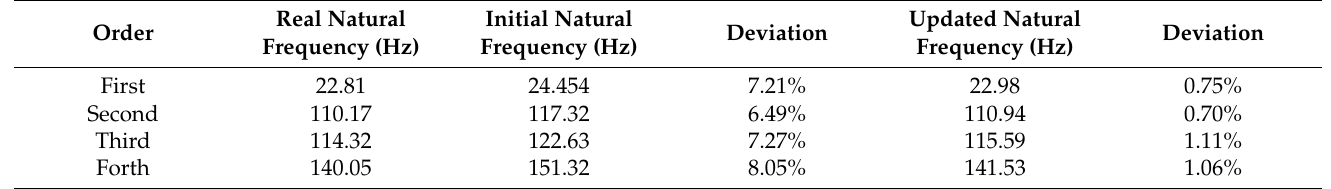
Table 12. The comparison of real natural frequency, initial natural frequency and updated natural frequency. Real Order